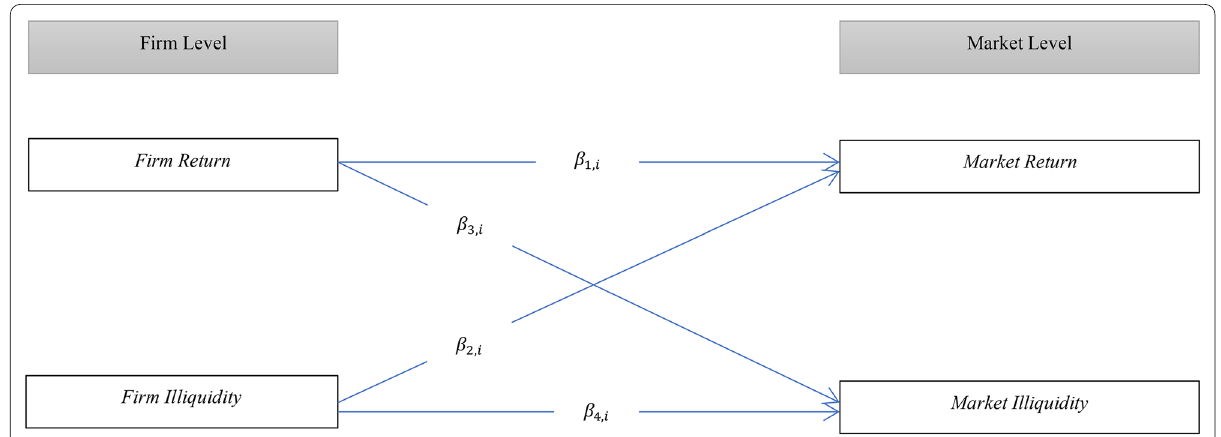
Fig. 1 Illustration of the four betas. Source: Adopted from Musneh et al.